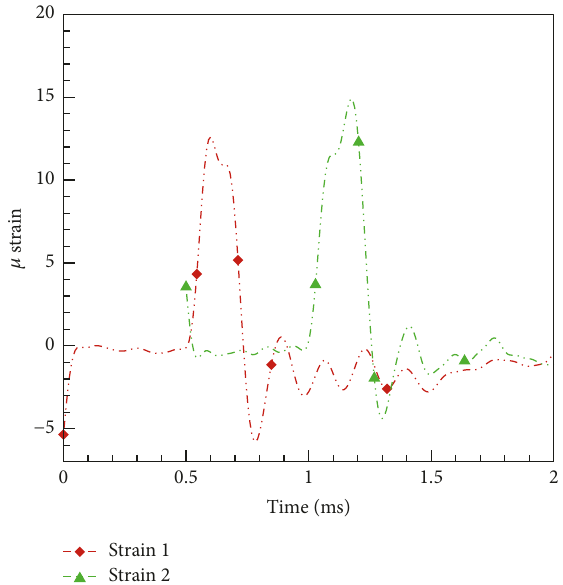
Figure 8: Strain signals recorded in two calibration tests.